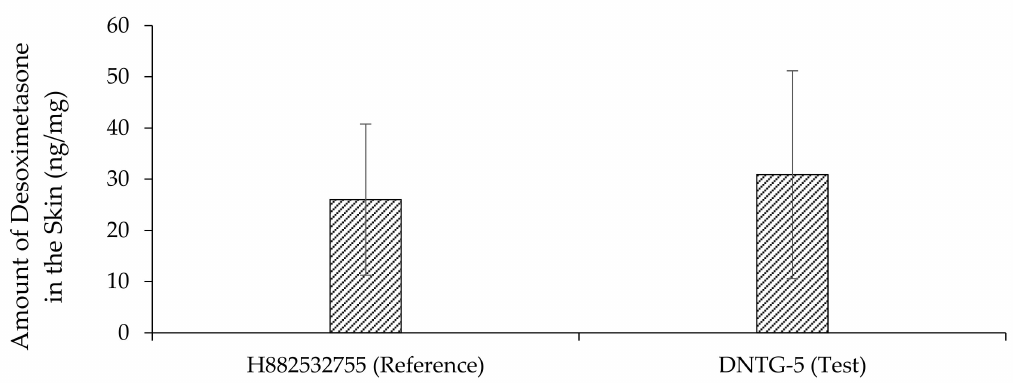
Figure 8. Amount of desoximetasone detected after 24 h in human cadaver skin ( n = 6, mean ± SD) using reference gel and test niosomal gel desoximetasone formulations.